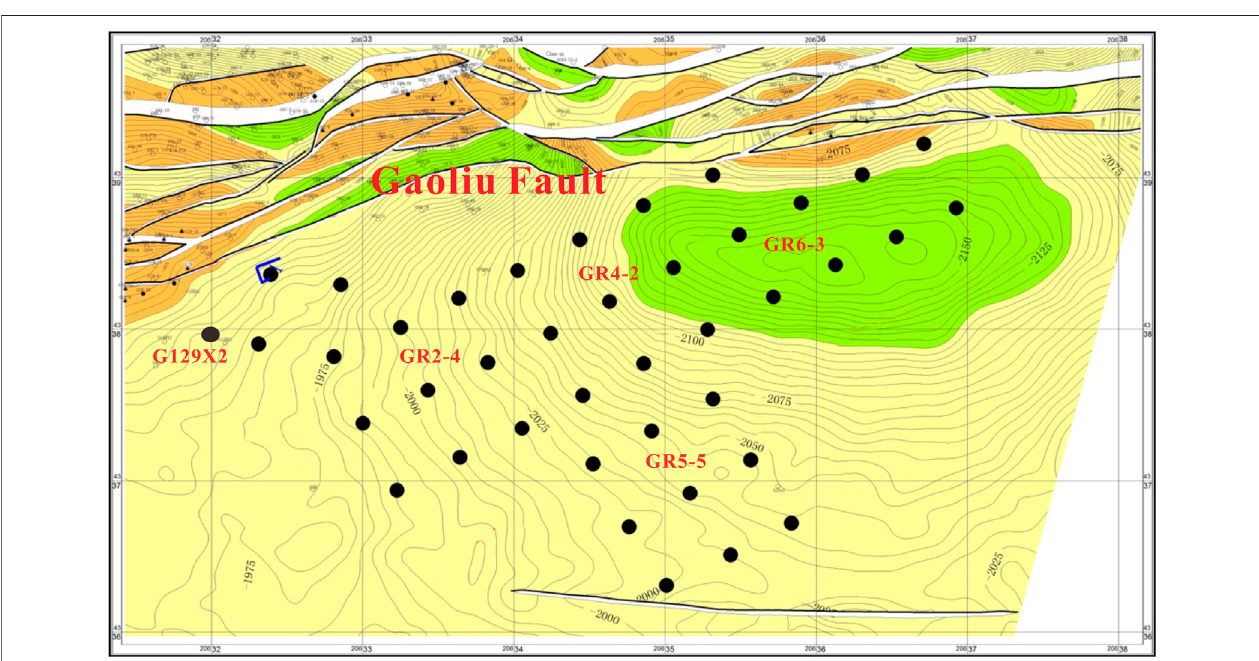
FIGURE 2 | The well locations in the study area are labeled by black